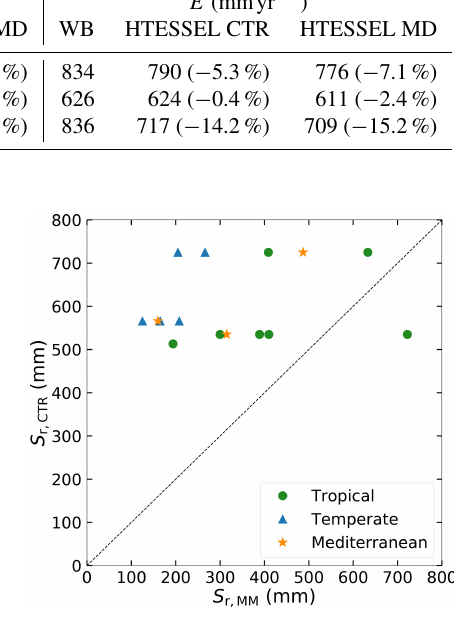
Figure 5. Catchment S r as estimated from the memory method ( S r,MM ) compared to the HTESSEL CTR parameterization ( S r,CTR ) in the catchment corresponding grid